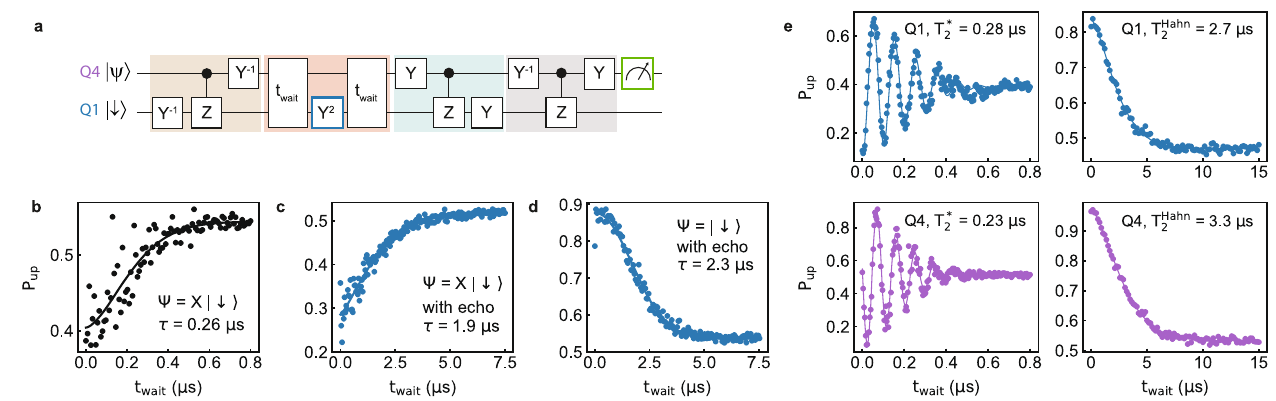
Fig. 2 Two-qubit phase fl ip code. a Circuit diagram. The encoding, decoding and correction are implemented using a combination of Y, Y − 1 and CZ gates. By adding a wait time (t wait ) after the encoding, phase errors will occur due to the dephasing of the qubits. Q4 is the data qubit and Q1 the ancilla qubit. b – d P up as a function of t wait when executing the two-qubit phase fl ip code, which gives a decay time τ . Results for the data qubit prepared in Ψ j i = X #j i and through single-qubit gates projected to a basis state for readout, without an echo pulse Y 2 ( b ), with an echo pulse Y 2 ( c ), and with an echo pulse with the data qubit prepared to Ψ j i = #j i ( d ). e For comparison we show the individual qubit and coherence T Hahn times for Q1 (blue) and Q4 (purple). dephasing T (cid:1) 2 2